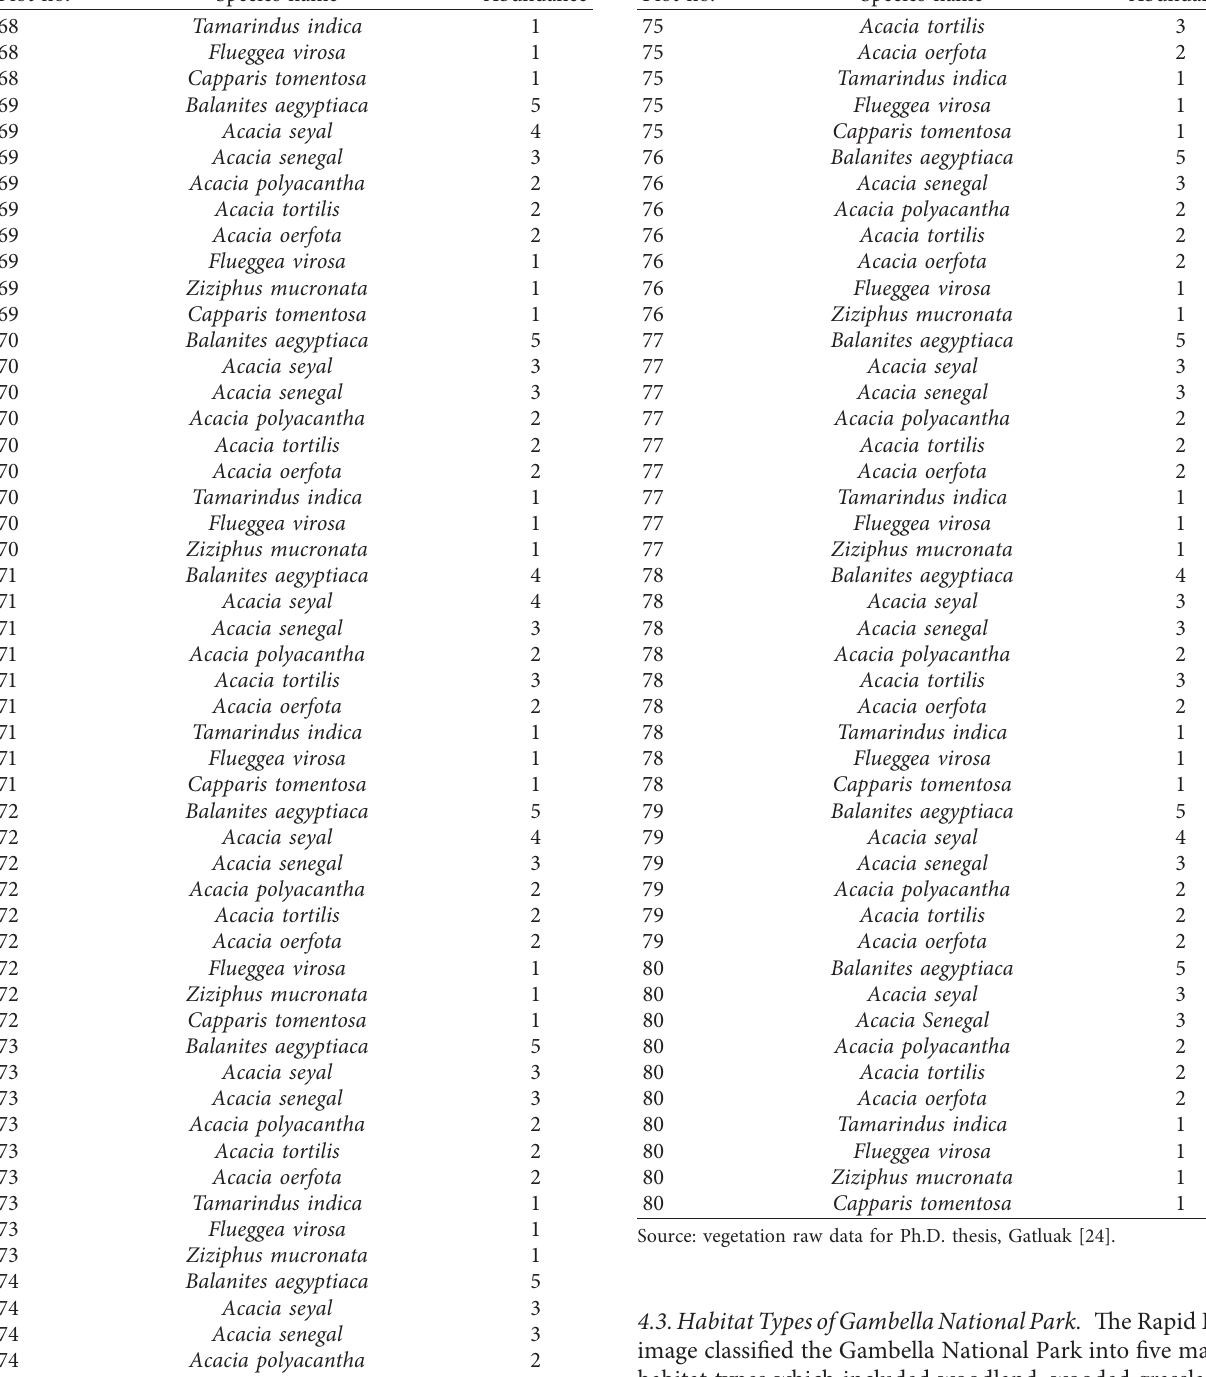
4.3. Habitat Typesof Gambella National Park. The Rapid